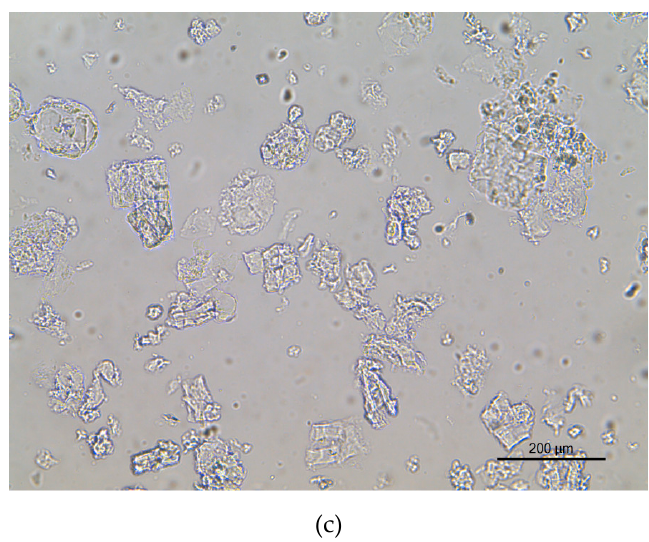
Figure 5. Optical microscopy images of dicarboxymethyl cellulose in aqueous solution: ( a ) DCMC 1, ( b ) DCMC 2, and ( c ) DCMC 3. Table 3. Dimensions of dicarboxymethyl